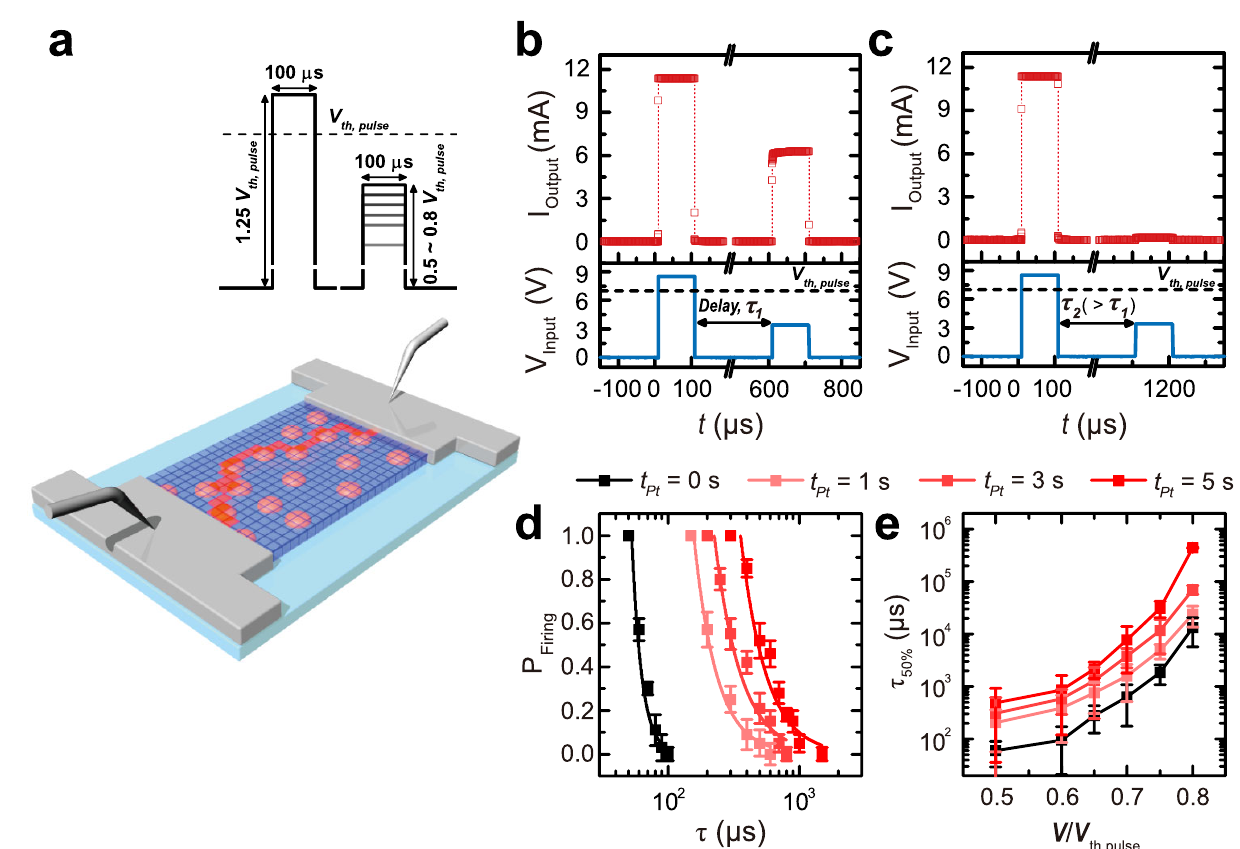
Fig. 3 | Enhancement of sub-threshold fi ring and memory effect in Pt-NP- embedded VO 2 . a Conceptual illustration of percolative (sub-)threshold fi ring of Pt-NP-embedded VO